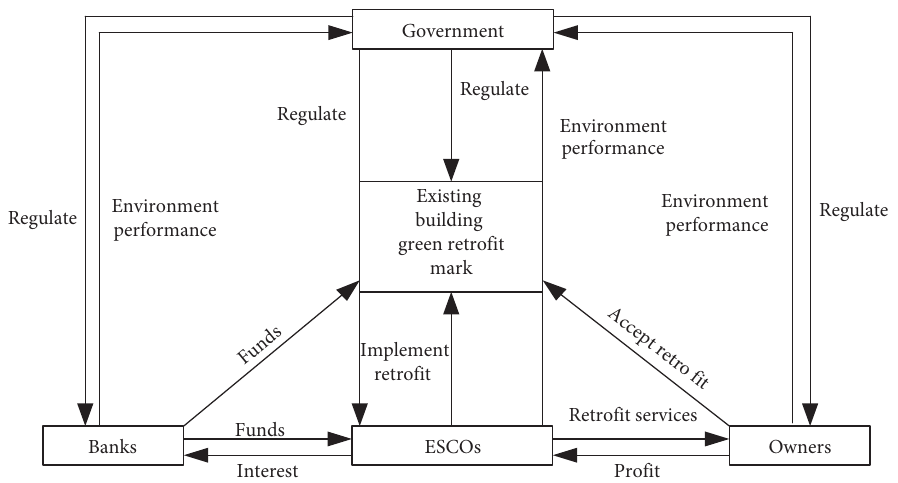
Figure 1: Relationship of the government, ESCOs, banks, and